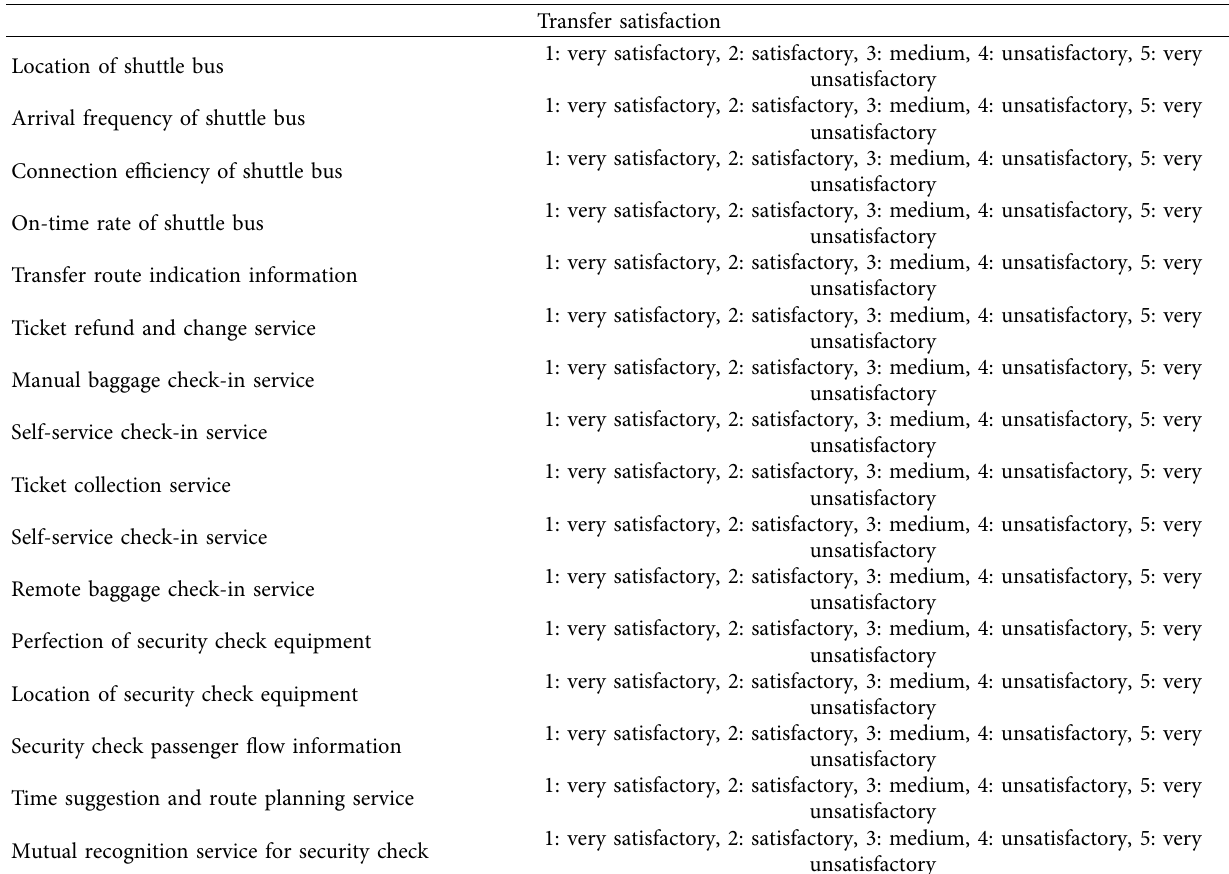
Table 3: Passengers’ transfer